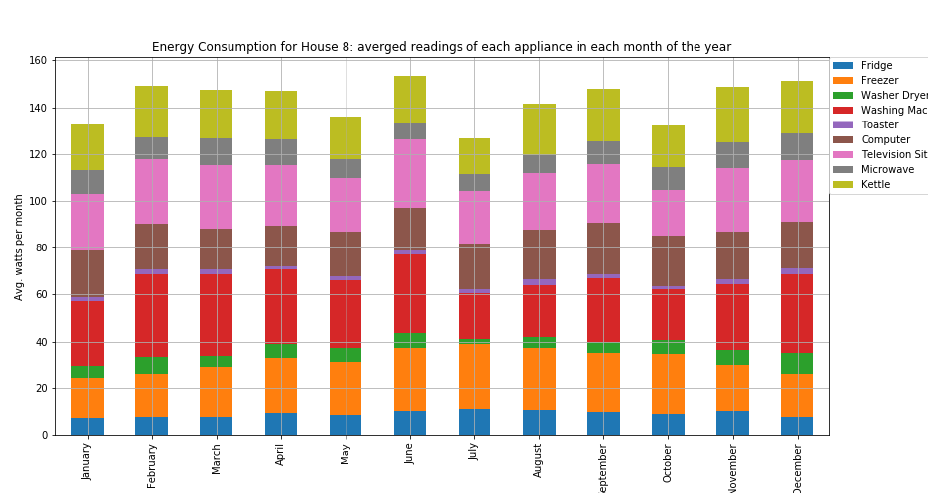
Figure A11. The average consumption per month of home appliances for house 8 with two occupants.